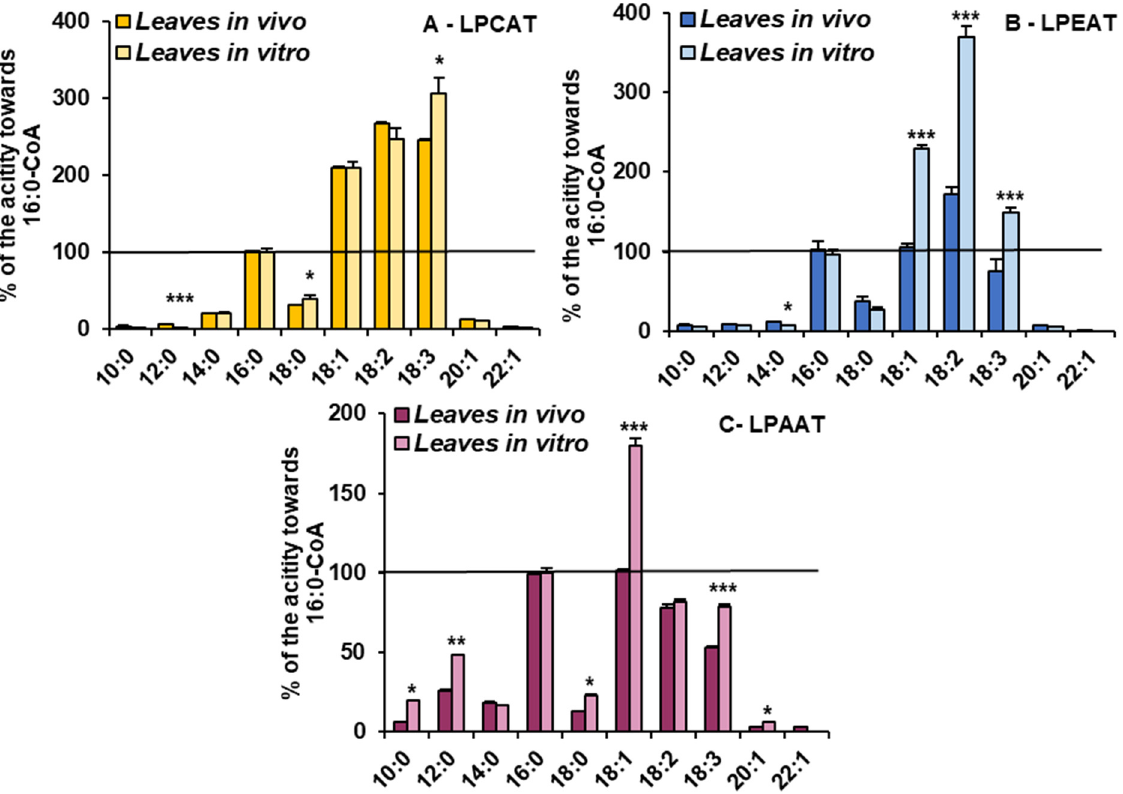
Figure 5. Acyl-CoA (indicated on the figure only by acyl component) preferences of LPCAT ( A ), LPEAT ( B ) and LPAAT ( C ) enzymes present in Camelina sativa leaves cultivated in two different growth conditions: in vivo and in vitro . Mean values and SD are presented (data from at least three independent assays). Asterisks indicate significant difference between the relative activity towards given acyl donor in assays with microsomal fractions of leaves cultivated in vivo and in vitro in a two-tailed Student’s t -test: * p ≤ 0.05, ** p ≤ 0.01, *** p ≤ 0.001.